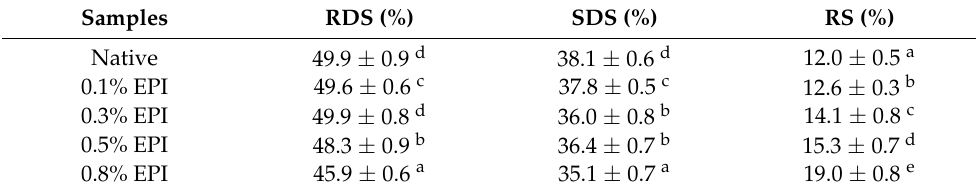
Table 5. In vitro digestibility of native and modified